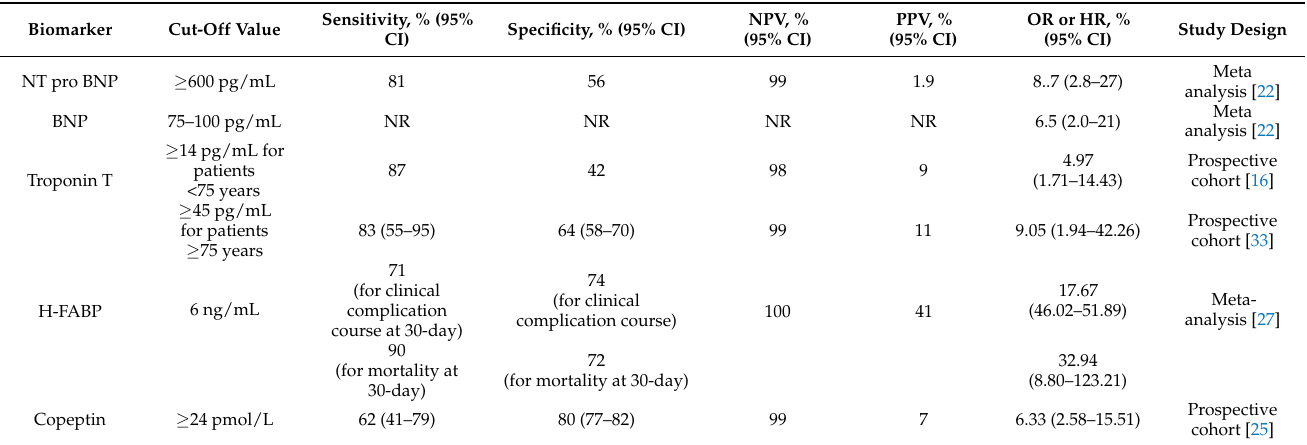
Table 2. Laboratory tests for prediction of early mortality in acute